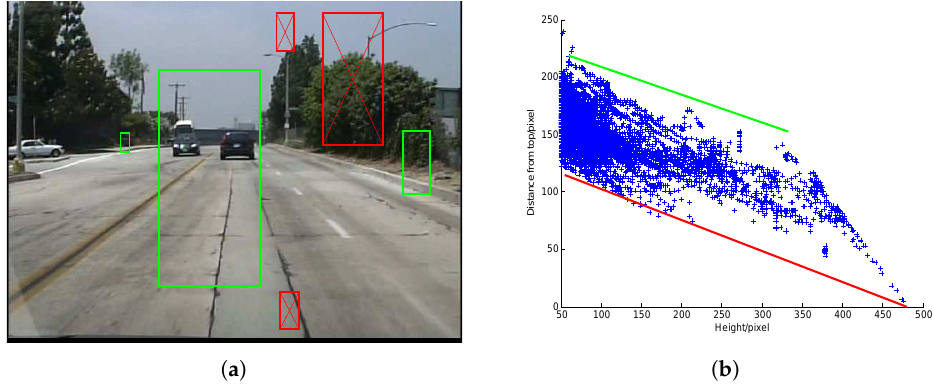
Figure 6. Illustration of GPC. ( a ) A pedestrian may be bounded by the green boxes, but may not be bounded by the red boxes; ( b ) ( h , y ) s of the pedestrian windows in the Caltech training set. They can be bounded by two straight lines.